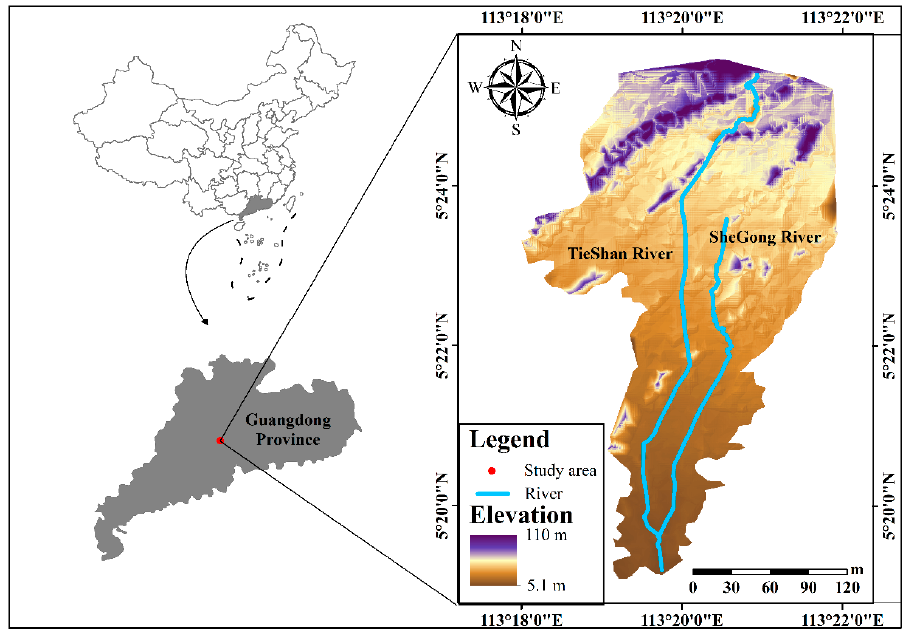
Figure 1. Topographic and water system in the study area.